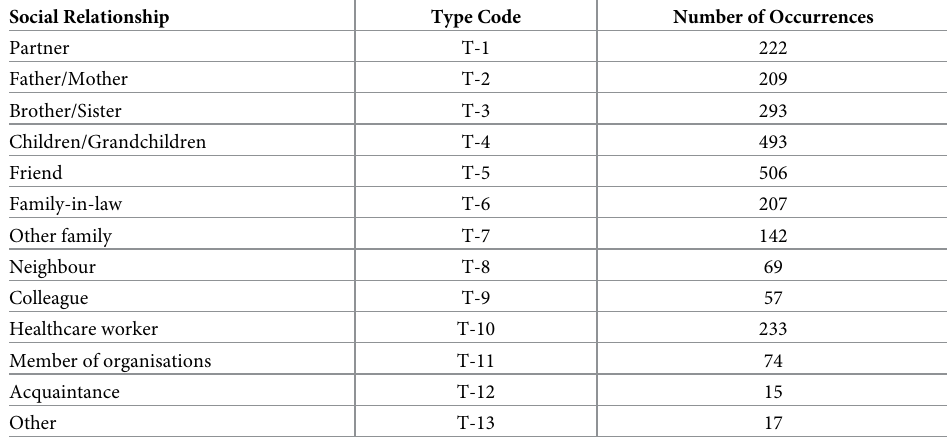
Table 2. 13 types of social relationships and their total number of occurrences in 303 egocentric